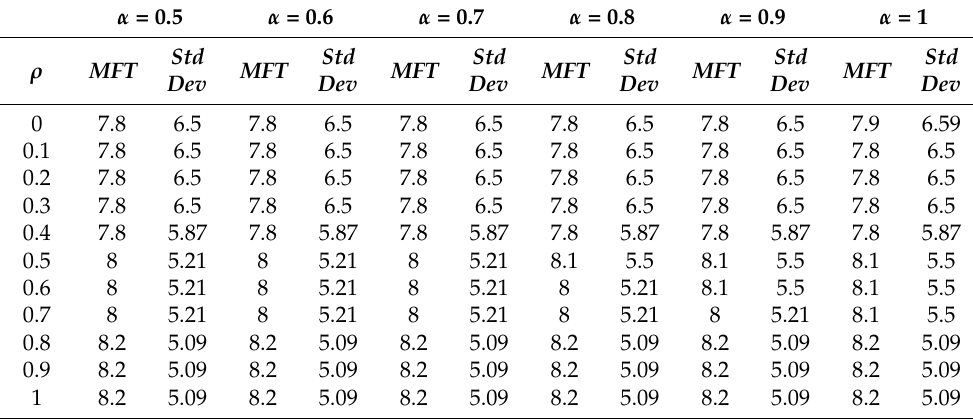
Table 10. The variation of MFT and standard deviation in function of ρ and α